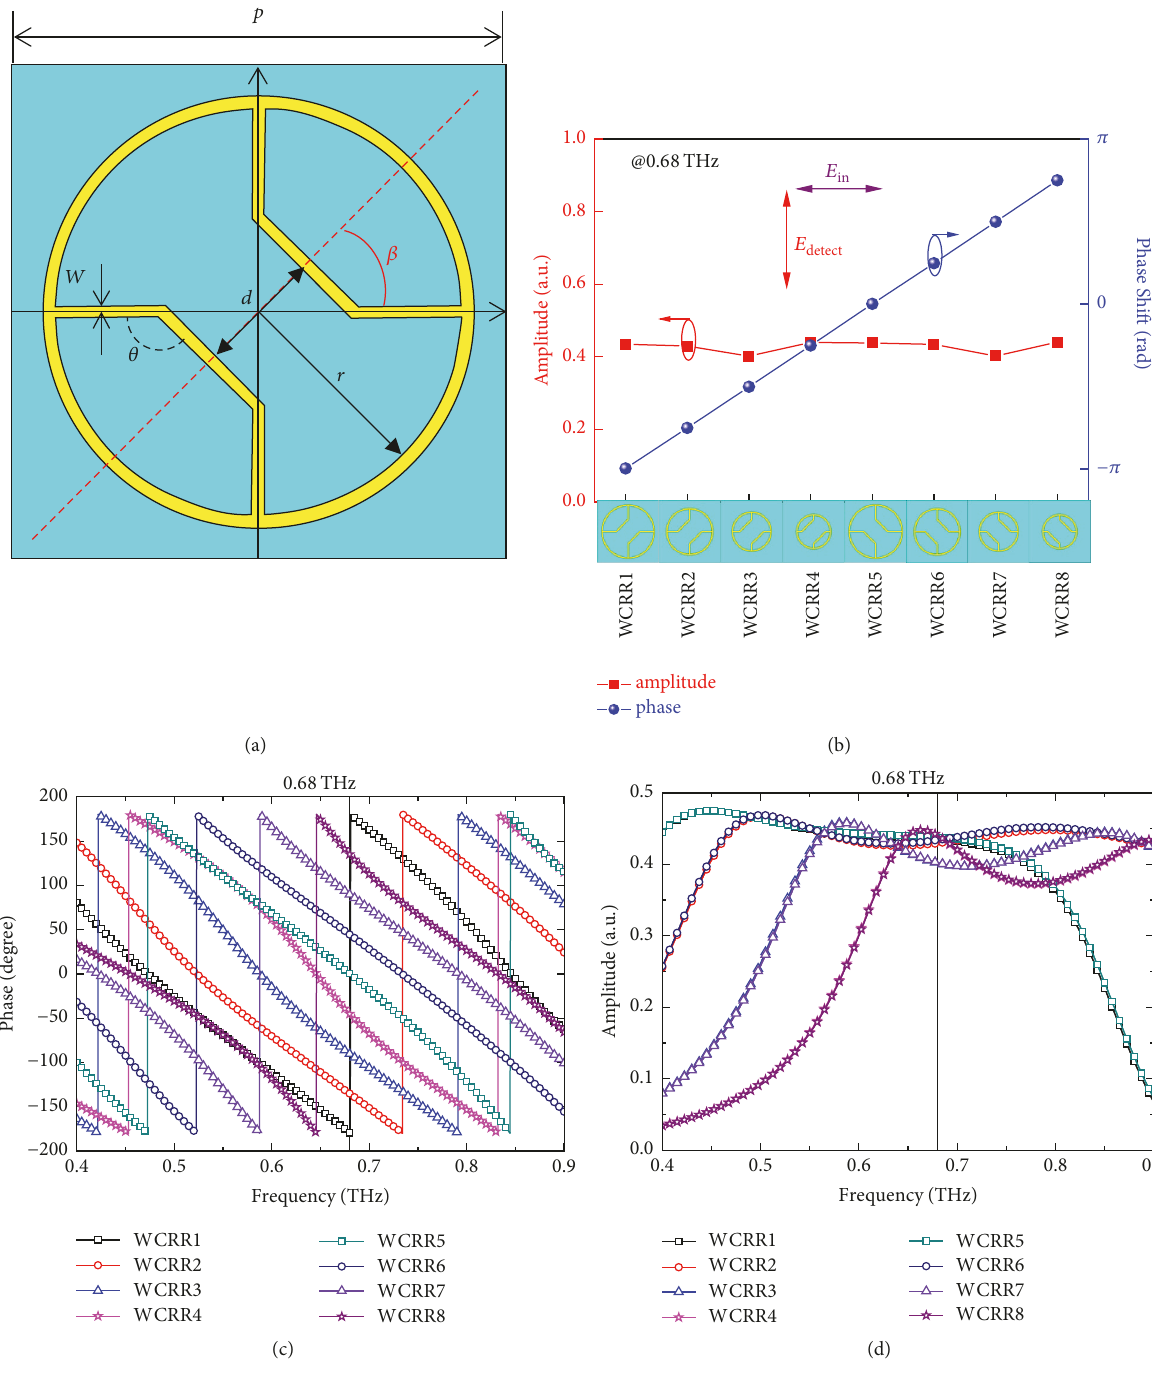
Figure 1: (a) Schematic views of the WCRR. (b) Schematic representation of eight resonators corresponding to eight different phases at 0.68 THz. (c, d) Simulated phase shift and transmission amplitude for eight WCRRs, respectively.